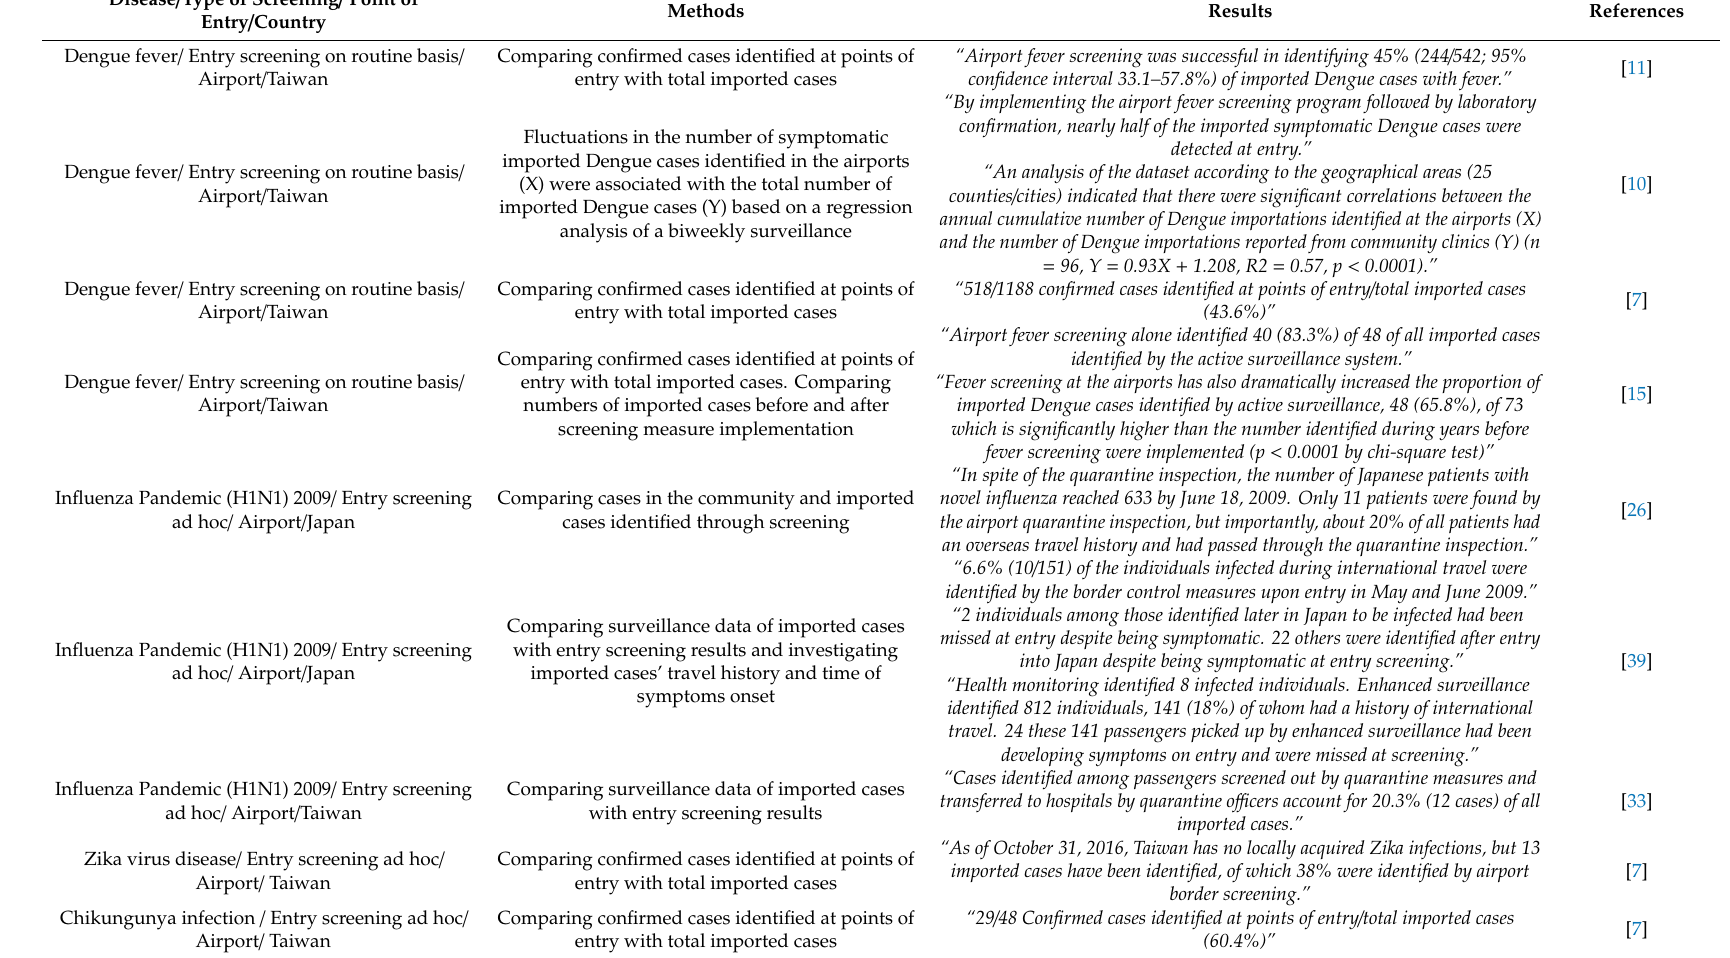
Table 10. Assessment of public health impact as reported by